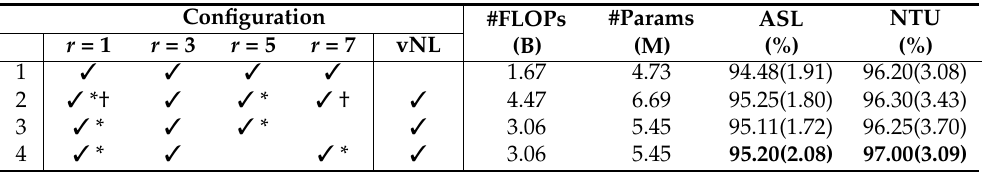
Table 2. Effects of various RFs in the NLRF block. The configuration r = 1 denotes the branch of atrous convolution with rate 1, and (cid:51) denotes that the branch was applied. The output feature maps of the branches with symbols * and † were further processed by the vNL block for capturing long-range dependencies. Configuration 3 adopted two vNL blocks to process branches r = 1 and 5 and branches r = 1 and 7, denoted by * and †, respectively. Numbers in parentheses indicate the standard deviation. A graphical illustration of the NLRF configuration is depicted in Figure 3c. Bold values indicate the highest classification accuracy among the four